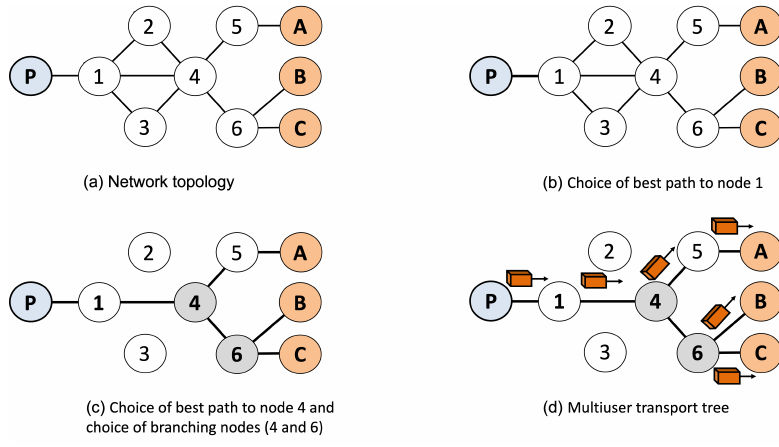
Figure 6. Multiuser transport